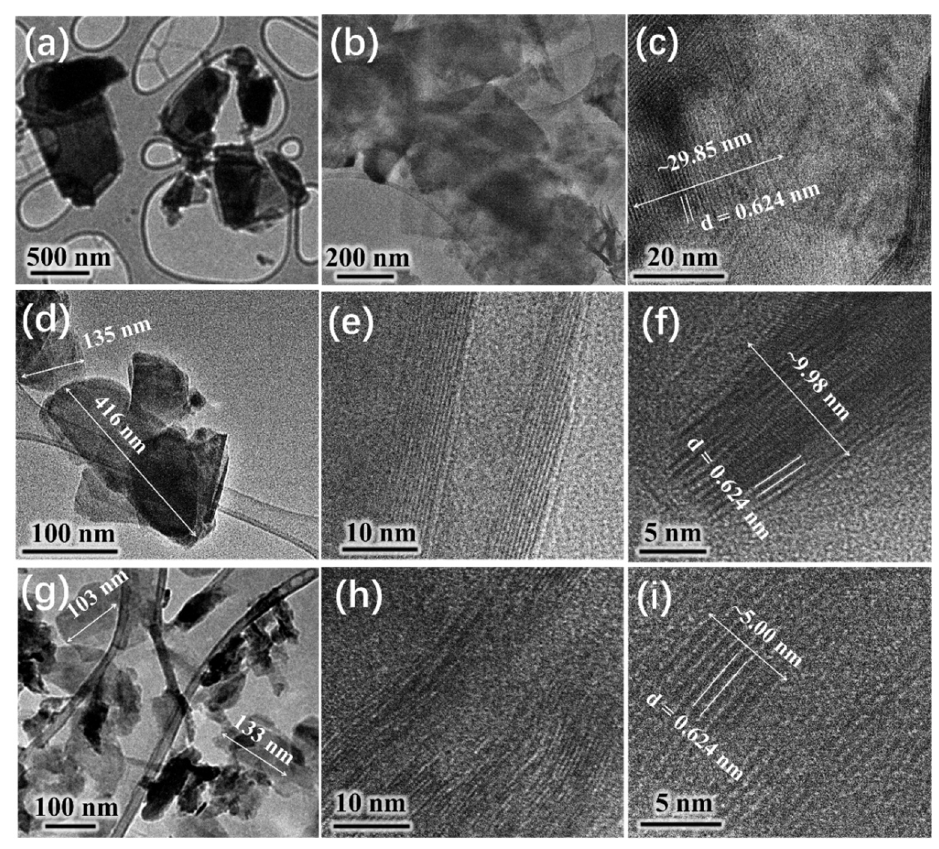
Figure 1. TEM images of the WS 2 products after sonication. ( a – c ) WS 2 -U, ( d – f ) WS 2 -L, and ( g – i ) WS 2 -S.